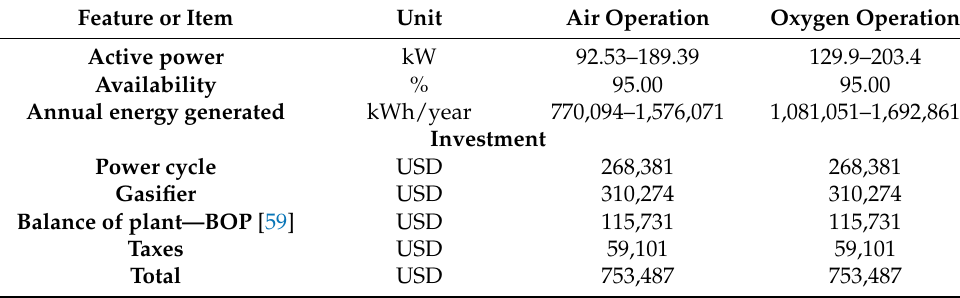
Table 8. Investment required to build the power system.